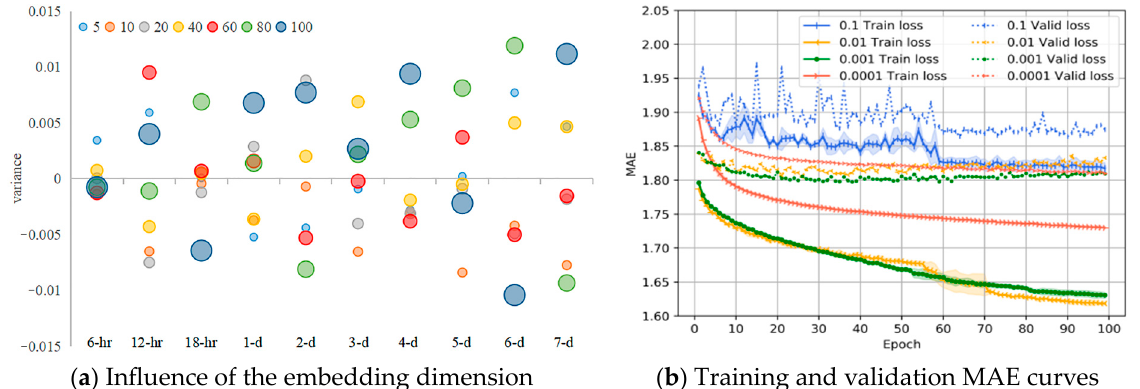
Figure 8. The experiment of node-embedding dimension and learning rate at 40 nodes.